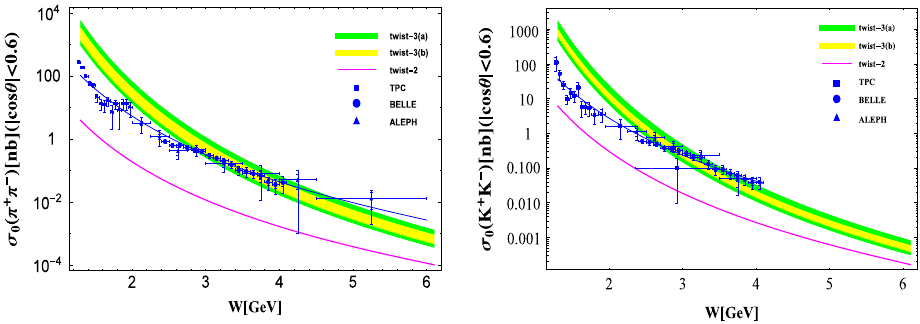
Fig. 4 Cross section for γγ → MM in the c.m. angular region | cos θ | < 0 . 6. The blue solid line is the result of a fit for the data among relevant ranges